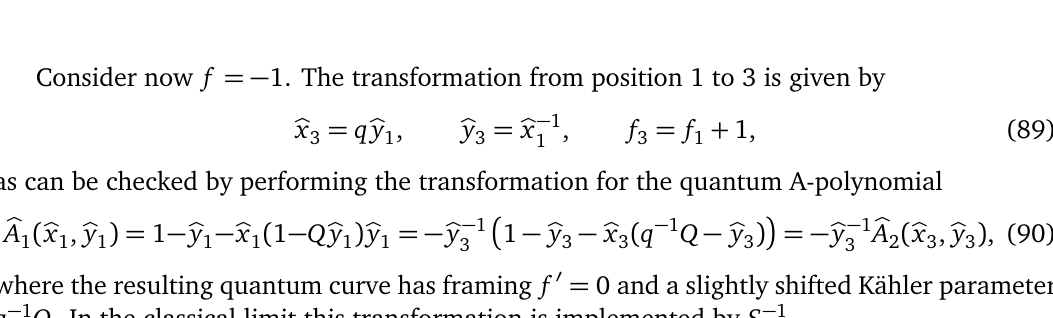
Figure 5: Toric diagram for resolved